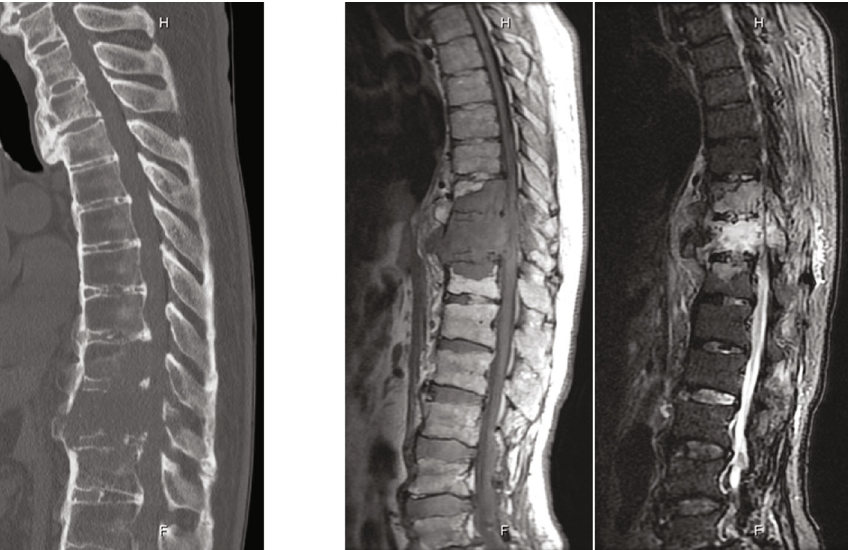
Figure 2: He presented with acute onset of severe back pain. CT and MRI reveal a fracture of the metastatic lesion in T10 –